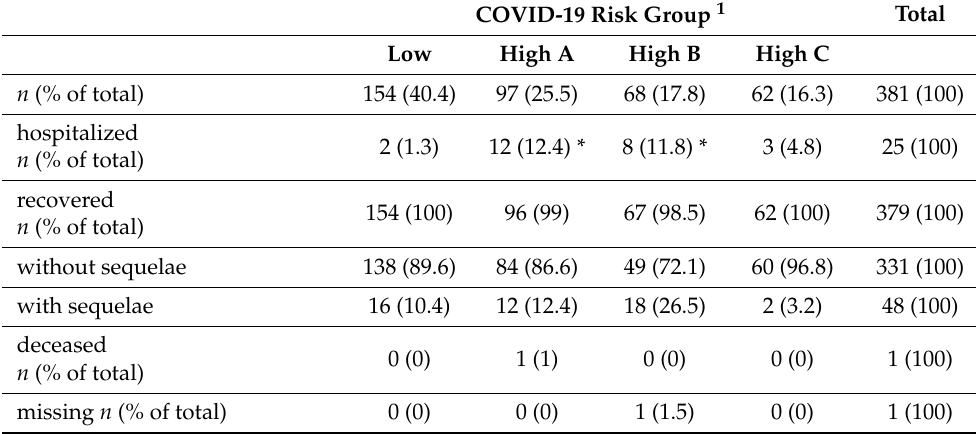
Table 4. Outcomes of COVID-19 patients included in the study according to risk stratification based on age, comorbidities and disease stage according to Derwand et al. [12]. The table does not include 11 patients with missing age (Table